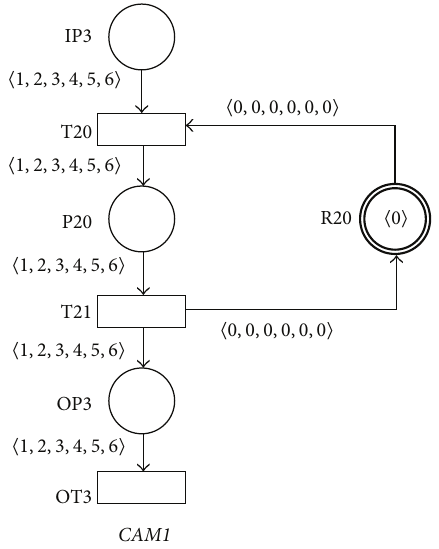
Figure 15: SNT agent net